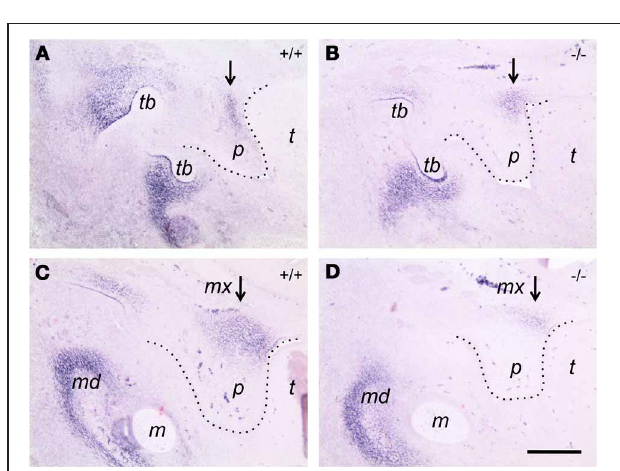
FIGURE 7 | Immunocytochemistry for tenascin-W on frontal sections of E13.5 Bmp 7 + / + (A,B) and Bmp 7 − / − (C,D) embryos. Sections through the anterior (A,C) and the posterior (B,D) palate are shown. Note tenascin-W protein staining extending into the palatal shelf in the Bmp 7 + / + embryo (A) , whereas it remains focussed to the region of the maxillary process in the Bmp 7 − / − embryo (B) . In the posterior palate, tenascin-W protein expression is reduced in the maxillary process of the Bmp 7 − / − (D) compared to the Bmp 7 + / + (C) embryo (arrows). mx , Maxillary process; p , palatal shelf; t , tongue; tb , tooth bud; md , mandible; m , Meckel’s cartilage. Bar, 200 μ m.